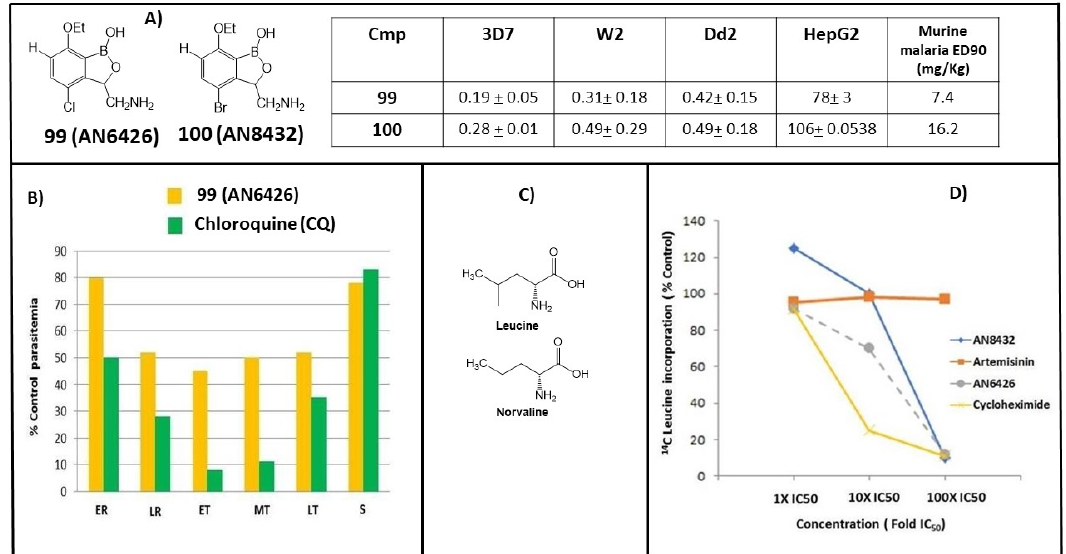
Figure 9. ( A ) In vitro (3D7 and W2/D2d P. falciparum strains ) and in vivo ( P. bergei strains ) antimalarial activity (IC 50 , µ M) of 99 (AN6426) and 100 (AN8432); ( B ) Stage specificity of 99 and CQ; ( C ) Chemical structures of Leucine and analogue Norvaline; ( D ) Effects of benzoxaboroles 99 and 100 and controls ART and Cycloheximide on [ 14 C] leucine incorporation by wild-type Dd2 strain P. falciparum . (Adapted from [88]).